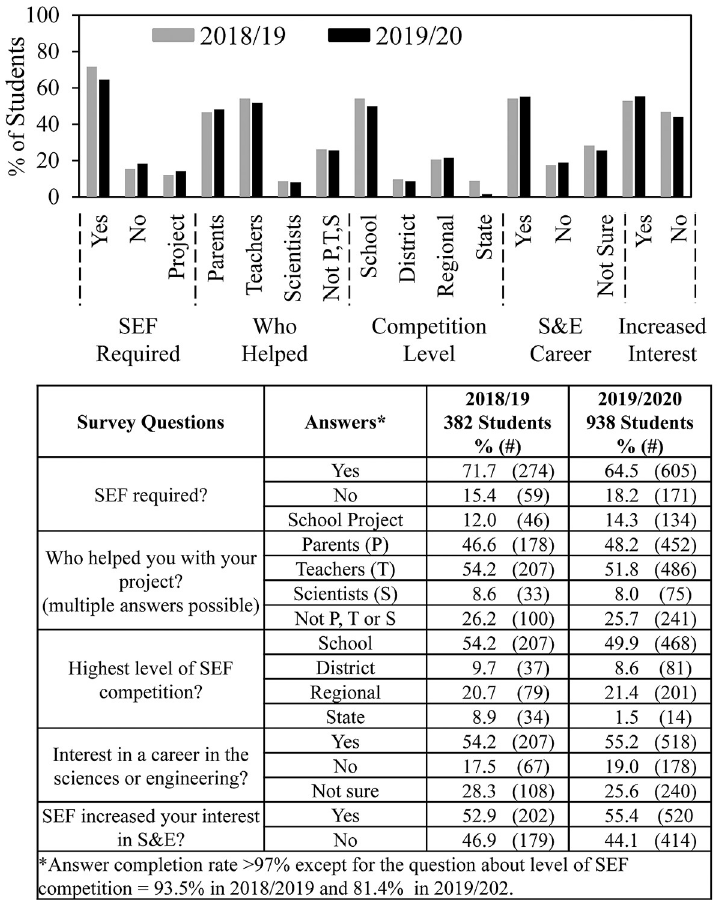
Fig 1. Some key features of SEF experience—2018/19 vs. 2019/20 student groups. Students’ ethnicity and SEF